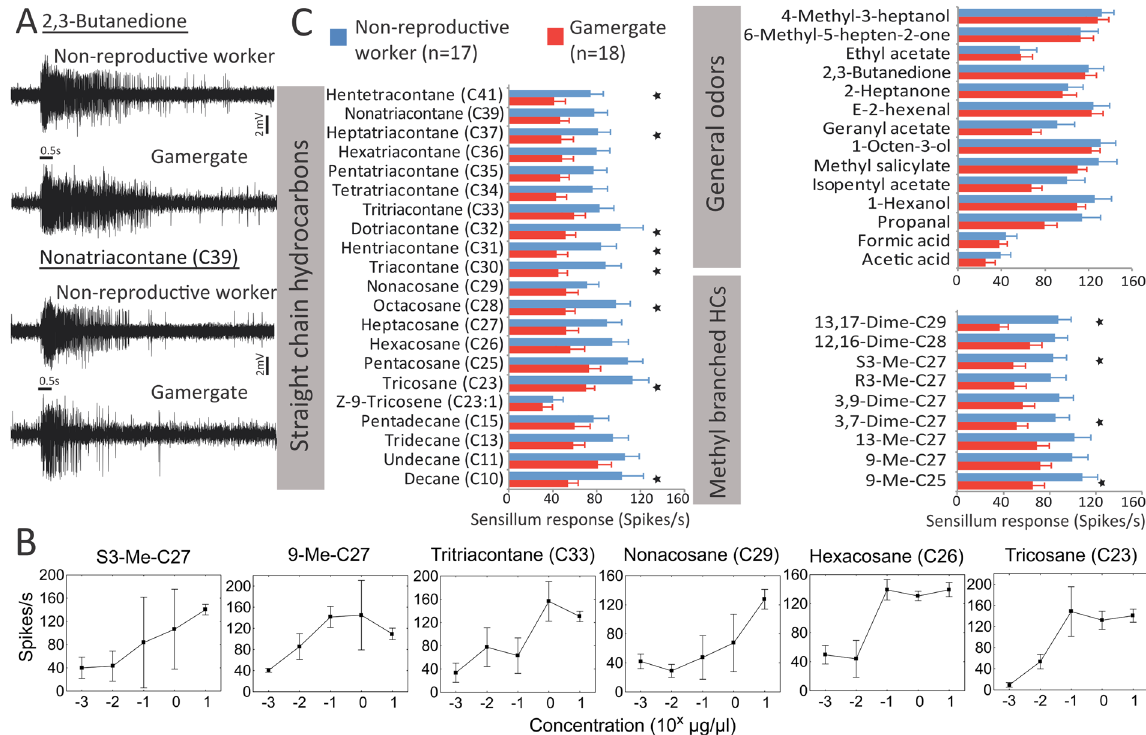
Figure 2. S. basiconica responses of H . saltator females to an odorant panel. ( A ) Response patterns of antennal sensilla basiconica of a worker and gamergate to 0.5 s non-hydrocarbon (2,3-butanedione) and long- chained hydrocarbon (Nonatriacontane, C39) stimuli. ( B ) Dose response curves for six hydrocarbons for 1 month old workers. N = 4 individuals for concentration 0.001 to 1 µ g/ µ l; N = 5 individuals, n = 18 sensilla for concentration 10 µ g/ µ l based on data from Fig. 4. ( C ) Antennal basiconic SSR responses to 44 hydrocarbons and general odorants in workers and gamergates of H . saltator with mean and SEM. Stars indicate statistically significant differences between the two groups at p < 0.05 (Repeated measures ANOVA, df 1F >